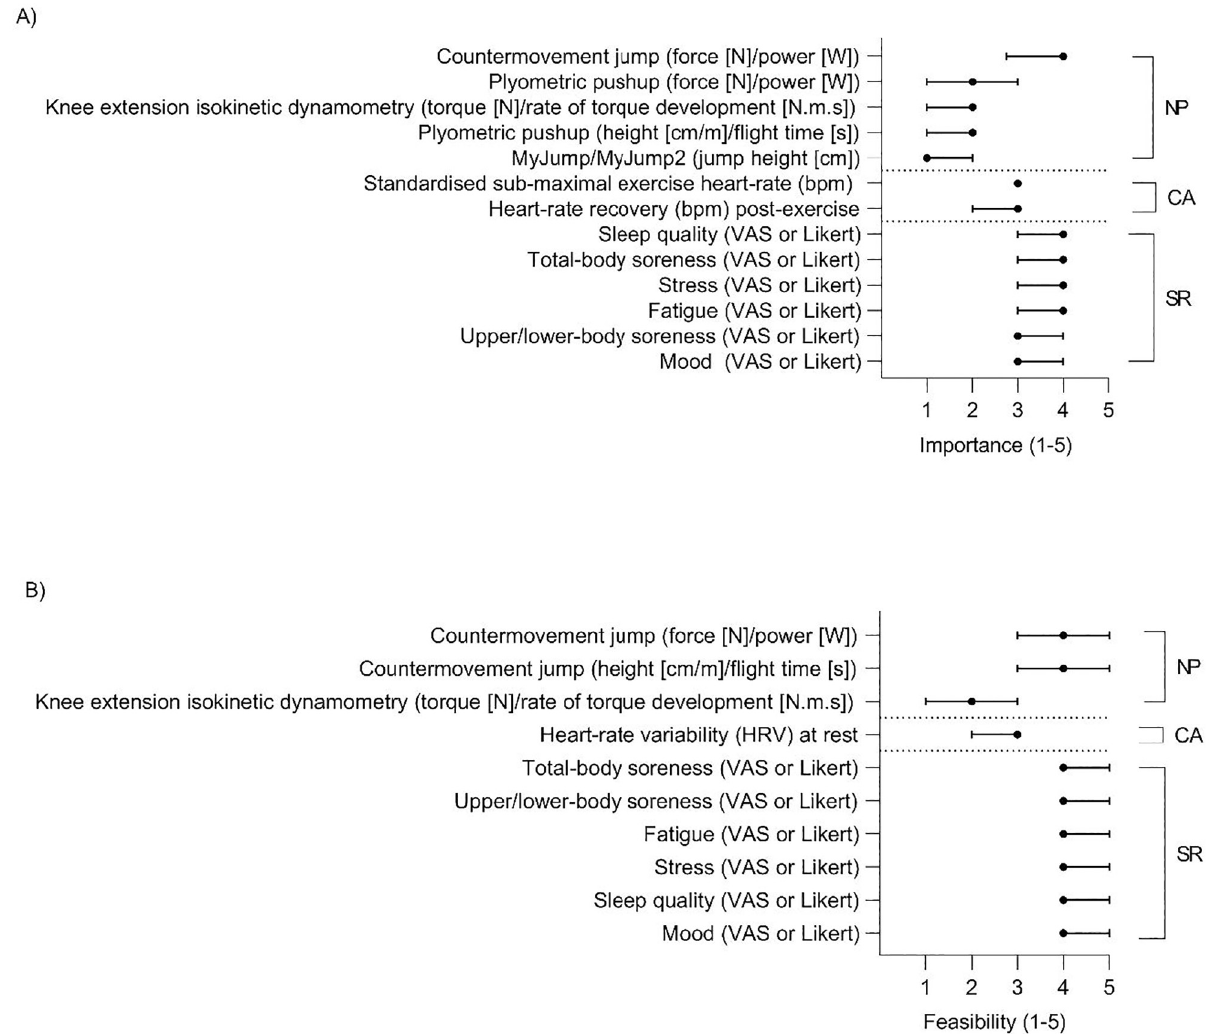
Fig 4. The SME ratings (median ± interquartile range [IQR]) of A) importance, and B) feasibility to implement of the items which achieved consensus in round one of the Delphi questionnaire for the neuromuscular performance (NP), cardio-autonomic (CA), and self-reported (SR) domains. For importance, the scale ranged from 1 –not at all important, to 5—extremely important. For feasibility to implement the scale ranged from 1 –extremely difficult to 5 –extremely easy. If end of the IQR error bar(s) is not visible it is due to this being located at the median. N—Newtons, VAS—Visual Analogue Scale,